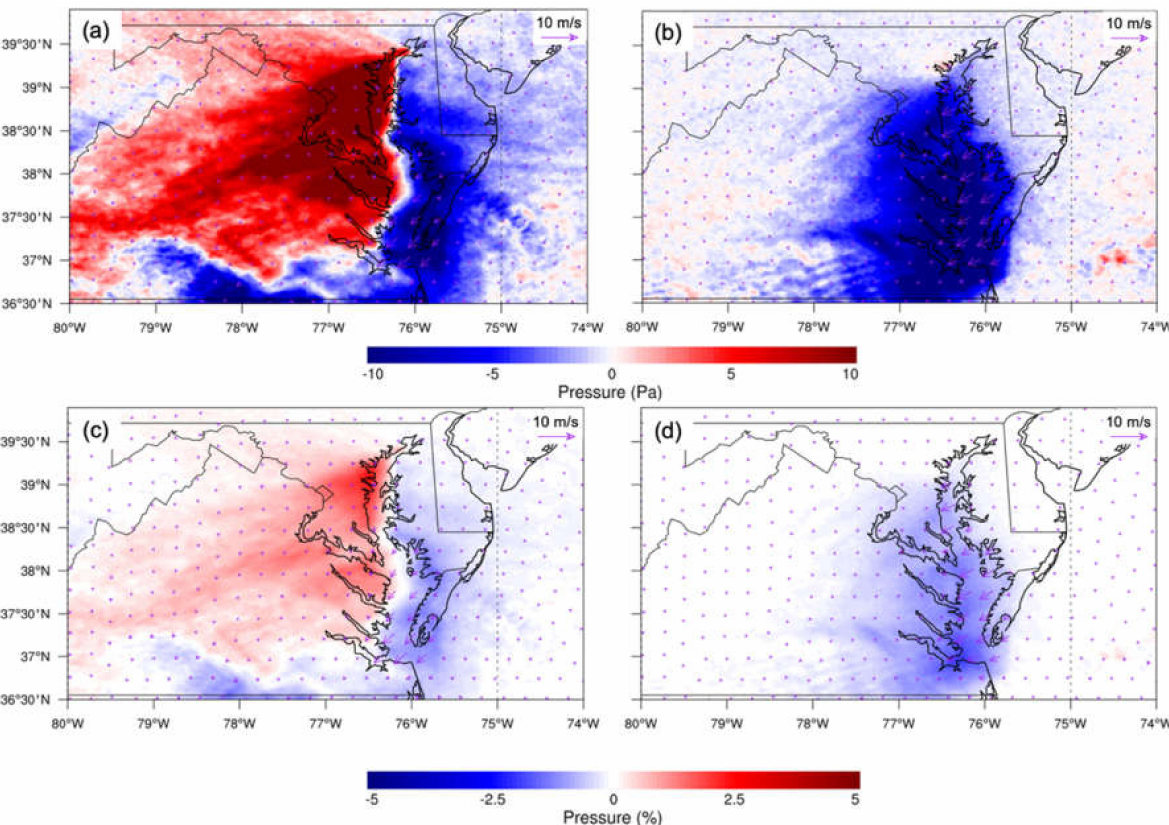
Figure 10. ( a ) Averaged absolute surface pressure difference (water minus nowater) at night. ( b ) Same as ( a ), but in the day. ( c ) Averaged relative surface pressure difference at night. ( d ) Same as ( c ), but in the day. The overlaid streamline is the corresponding surface wind difference. Daytime is defined as 1000–0000 UTC (or 06:00–20:00 local time); nighttime is defined as 0000–0900 UTC (or 00:00–06:00 and 20:00–00:00 local